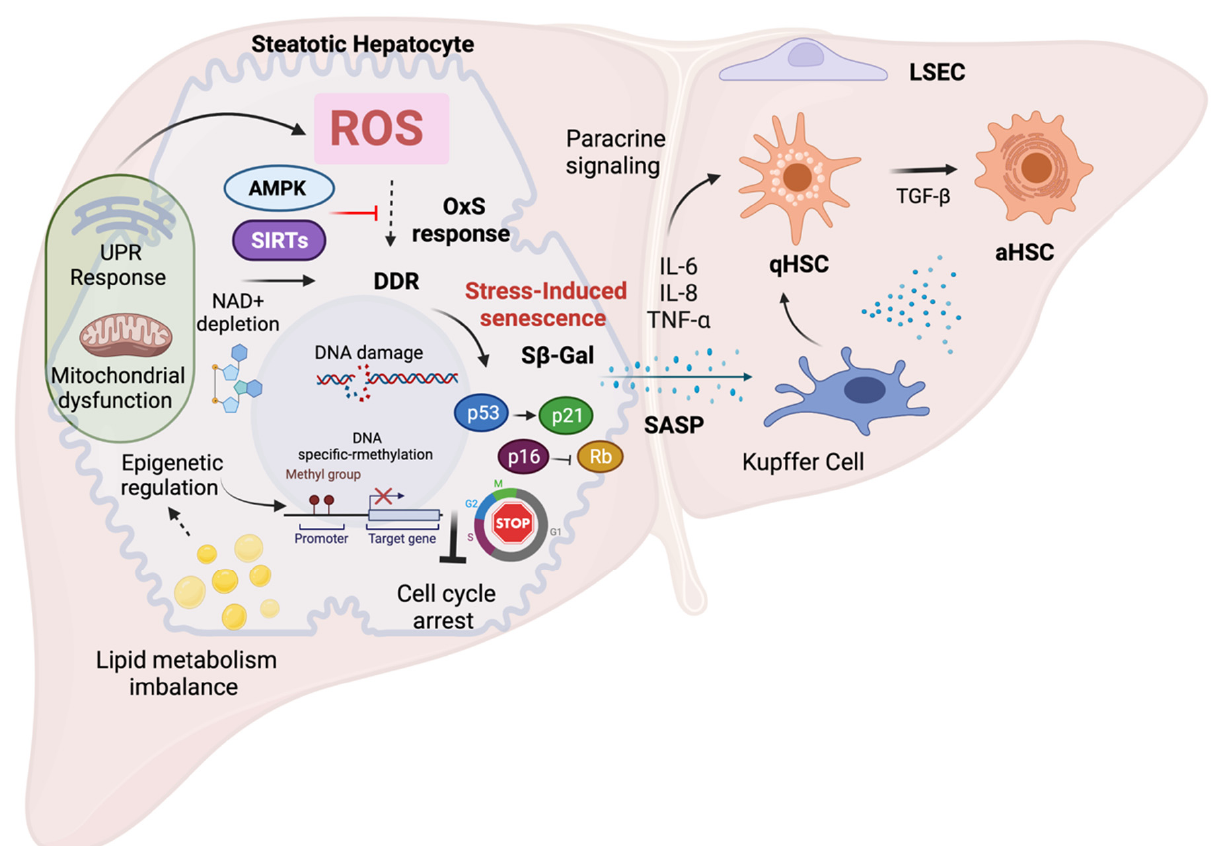
Figure 2. Mechanisms and features of oxidative stress-induced senescenceExcess ROS triggers premature senescence as part of the cellular stress response via activation of the DNA-damage response with concomitant activation of p53-p21 and p16-Rb pathways. This causes prolonged cell cycle arrest and prevents the activation of the cell death program and limits liver damage. Impaired lipid metabolism during NAFLD induces organelle dysfunction, contributing to OxS and senescence. Chronic oxidative stress during NAFLD leads to dysregulation of several factors such as depletion of NAD + levels with diminished SIRT expression and downregulation of AMPK signaling, leading to deleterious cellular senescence. These pathways can be potential therapeutic targets to control cellular senescence via modulation of OxS. Other cellular response mechanisms such as epigenetic regulation, can directly influence cellular senescence, e.g., via p16 activation. Epigenetic changes have been demonstrated to be induced by lipid accumulation and OxS during NAFLD. Finally, the SASP along with the production of pro-inflammatory factors can influence neighboring cells by paracrine signaling (bystander effect), and allows activation of non-parenchymal cells contributing to NAFLD